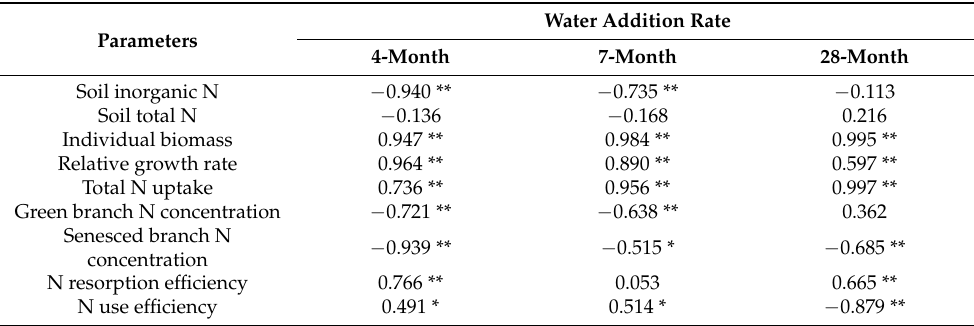
Figure 3. Soil inorganic N ( a ) and total N ( b ) concentrations in response to different water treatments at three growth stages (4 months, 7 months and 28months). Values are shown as the means ± se ( n = 4). Bars with different lowercase letters indicate significant differences among treatments at the same growth stage at p < 0.05. Table 3. Pearson’s correlation coefficients between water addition rate and measured plant trait and soil N parameters for plants at 4-, 7-, and 28-month age.